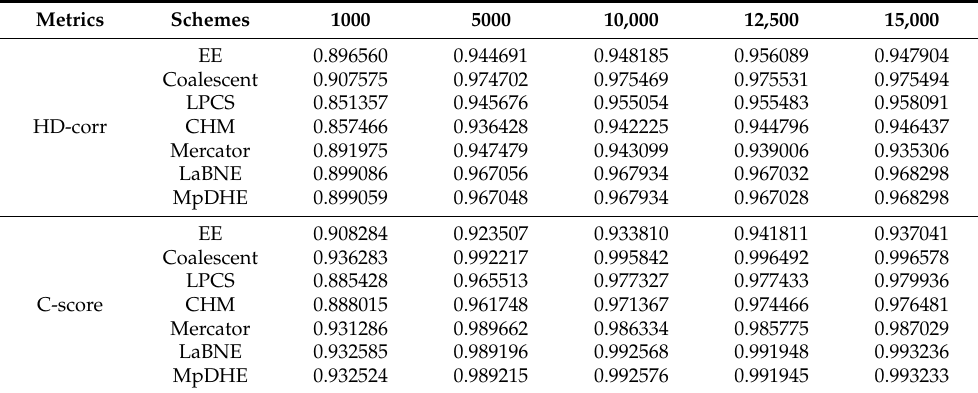
Table 2. The hyperbolic embedding performance on different network scales.